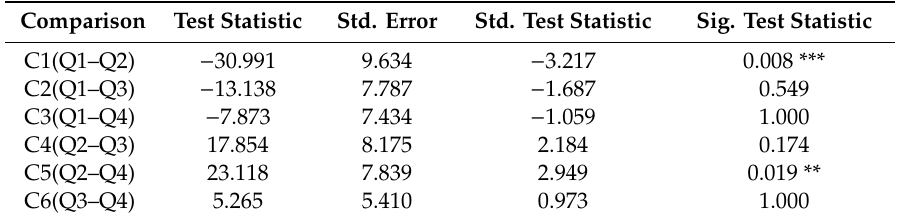
Table 4. Pairwise comparison test results.